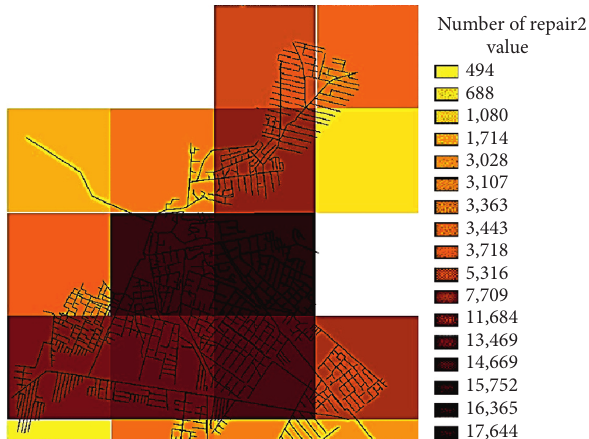
Figure 24: The total number of Hazus SR2 damage under PGA2%.